Question: What type of chart is this?
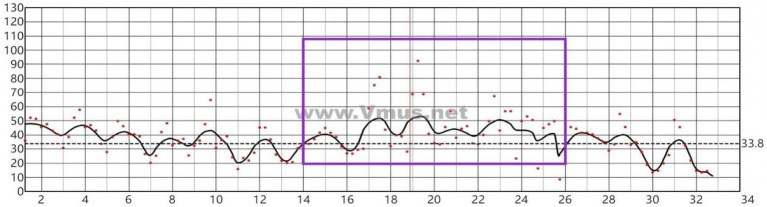
Answer: line